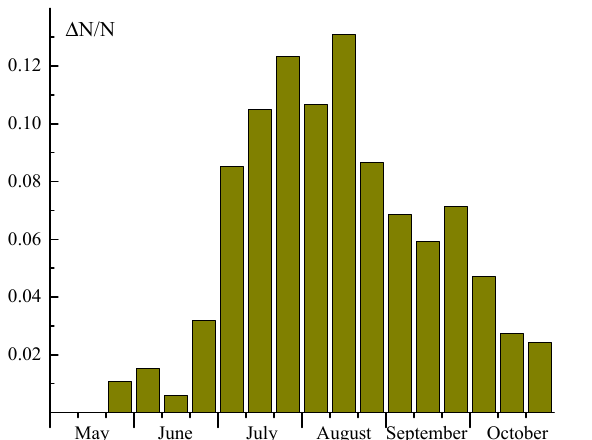
Figure 2. Route map of expeditions (measurement sites), boundaries of analyzed sea areas (dash- dotted lines) and test continental areas (red lines).